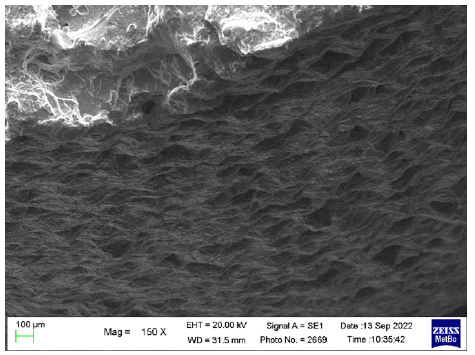
Figure 4. Close-up of shot-peened the external surface.